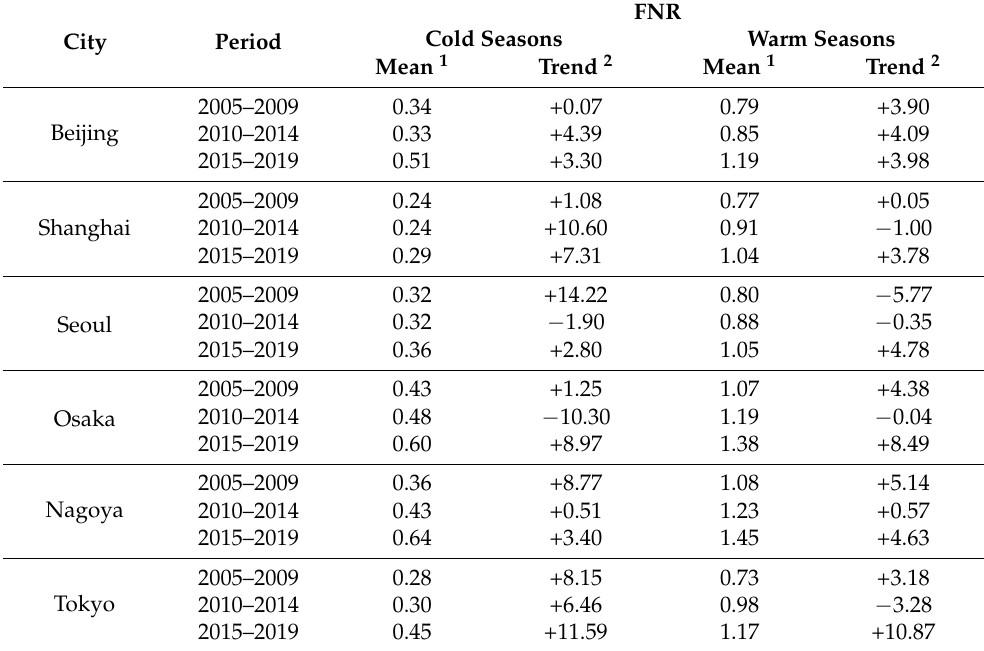
Table 1. Summary of city-level grid point analyses of the mean and trend of FNR during the 5-year periods of 2005–2009, 2010–2014, and 2015–2019 averaged over cold and warm seasons. FNR Cold Seasons Warm Seasons City Period Mean 1 Trend 2 Mean 1 Trend 2